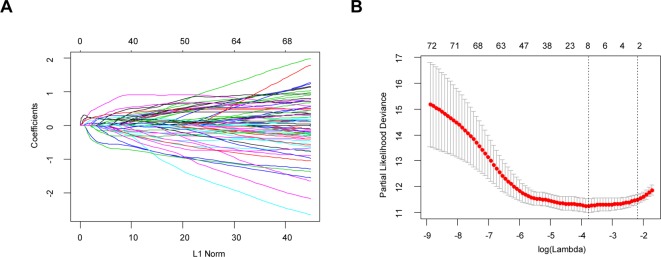
Identification of independent prognostic TME-related genes by LASSO regression. (A) LASSO coefficient profiles of 73 prognostic genes. (B) Ten-time cross-validation for tuning parameter selection in the LASSO model.